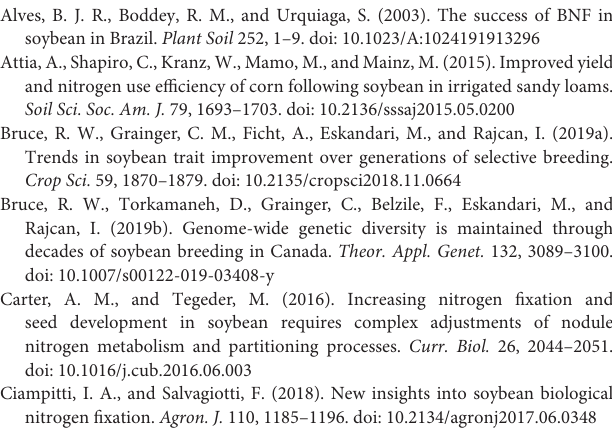
2017 growing seasons. Supplementary Table 2 | Analysis of variance (ANOVA) table for the plant parameters tested across 44 soybean cultivars in two production years (2016 and